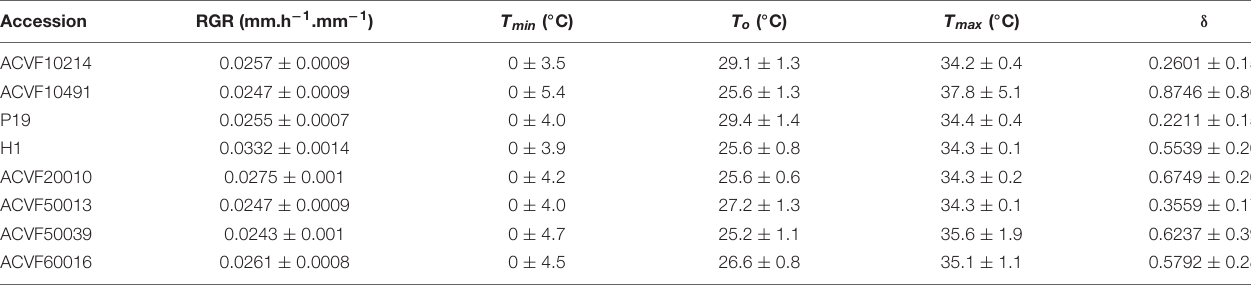
TABLE 3 | Estimated values ( Pr > t ) of the parameters for the beta model fitted to the relative growth rate of the radicle RGR-rt data of Lolium perenne accessions in response to constant temperature during heterotrophic growth.